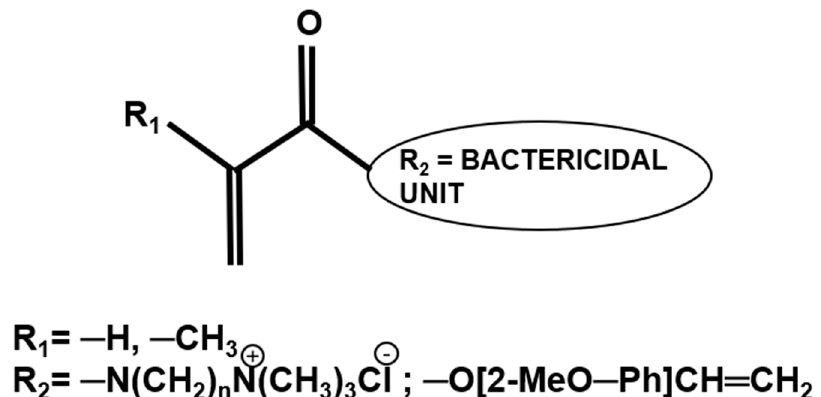
Figure 2. Chemical structure of (meth)acrylate (R 1 ) monomers bearing antibacterial pendant groups (R 2 ).